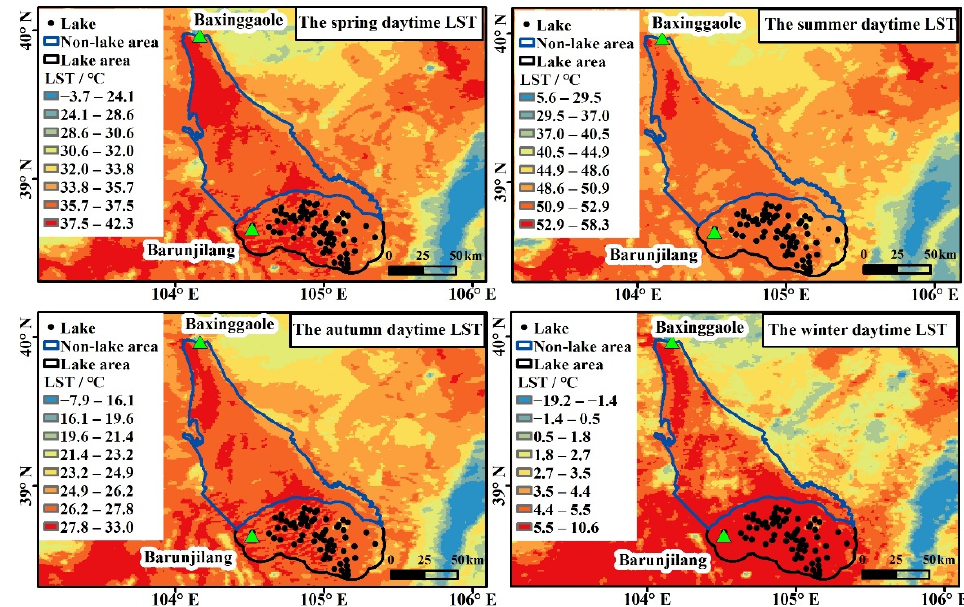
Figure 3. Distributions of average LST during the daytime in the lake and non-lake areas.